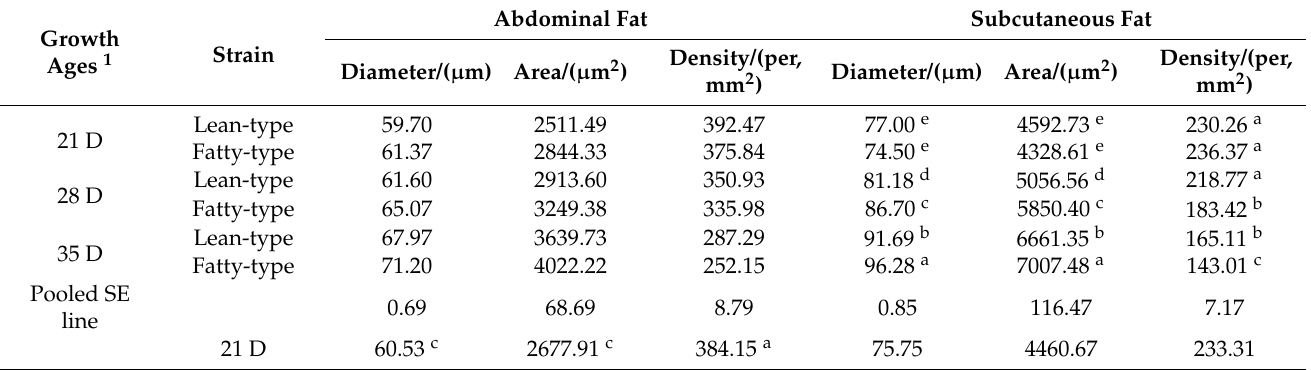
Table 4. Comparison of adipocytes between Lean-type ducks and Fatty-type ducks at different growth